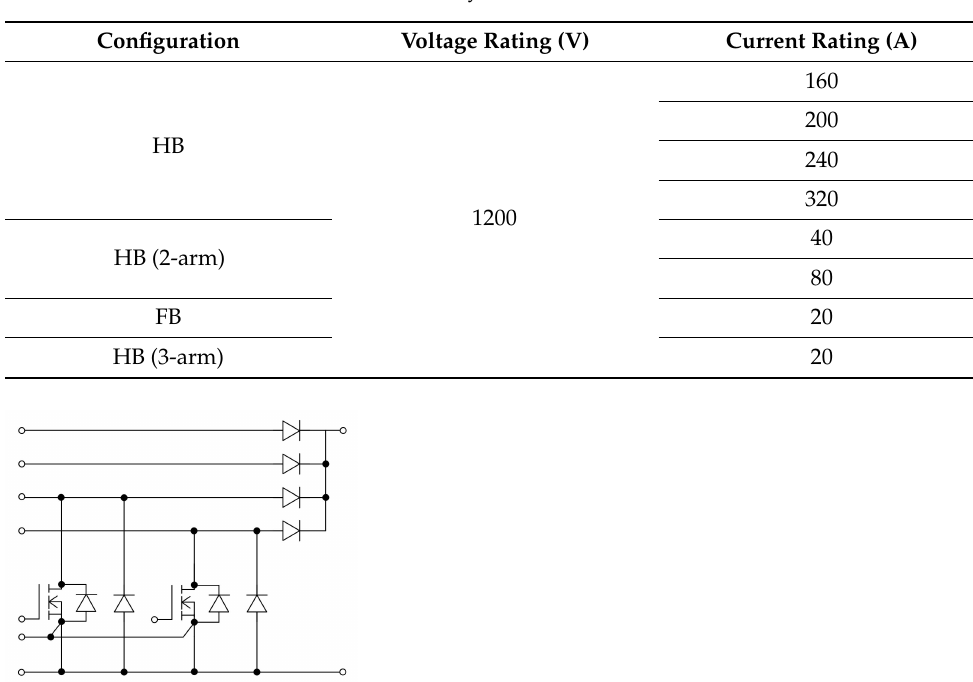
Table 19. Commercial SiC MOSFET modules by SemiQ.